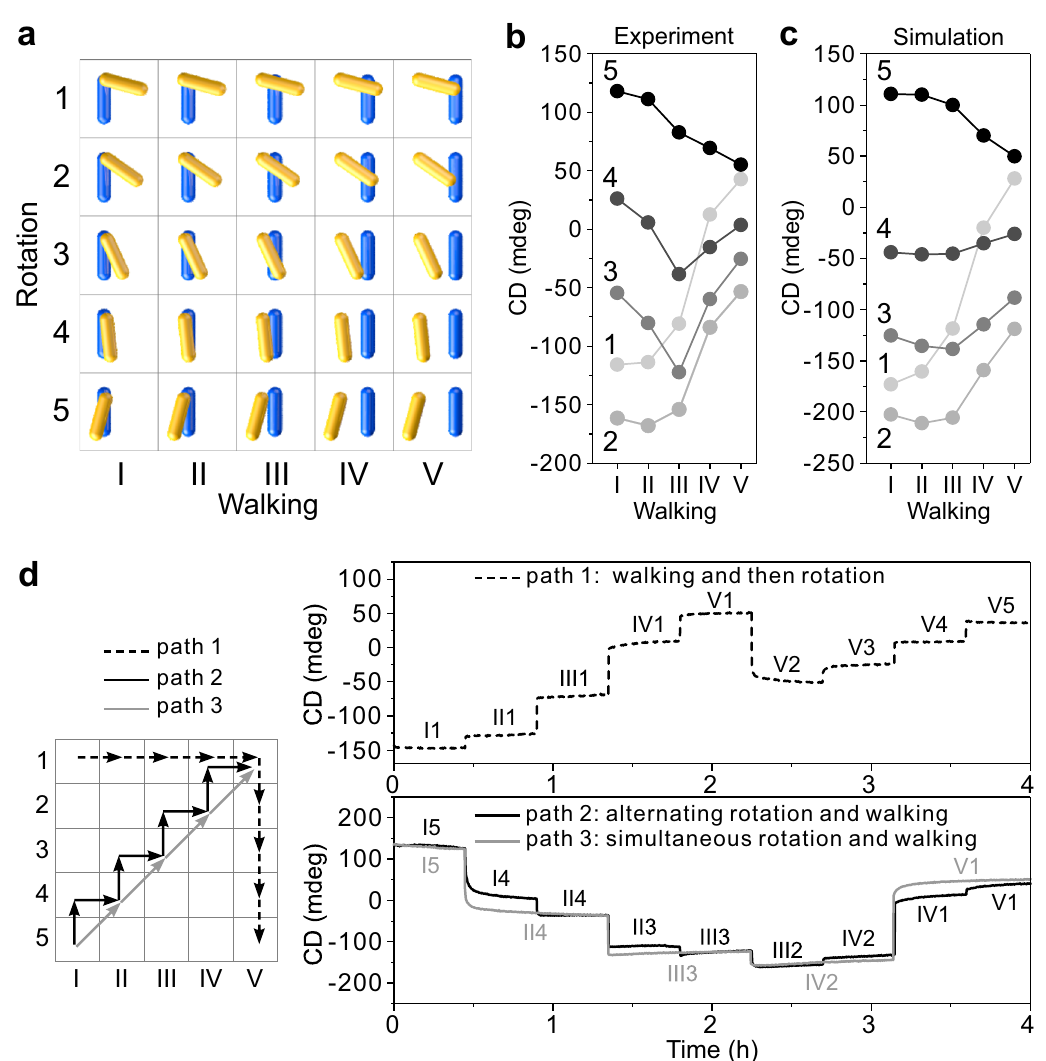
Fig. 2 Optical characterizations of the UNITs. a 25 states of the UNIT with 5 rotation positions and 5 walking positions. b CD intensities extracted at 721 nm at these 25 states. c Simulated results for the 25 states. The rotation angles for positions 1 – 5 are 15°, 35°, 65°, 85°, and 105° in the calculations. d Time-course measurements along three paths. Path 1 (black dashed): a walking route followed by a rotation route. Paths 2 and 3: alternating (path 2, black) and simultaneous (path 3, gray) rotation and walking from state I5 to state V1. The arrows indicate the directions of the movements. Concentrations of the AuNRs in all the samples are about 1